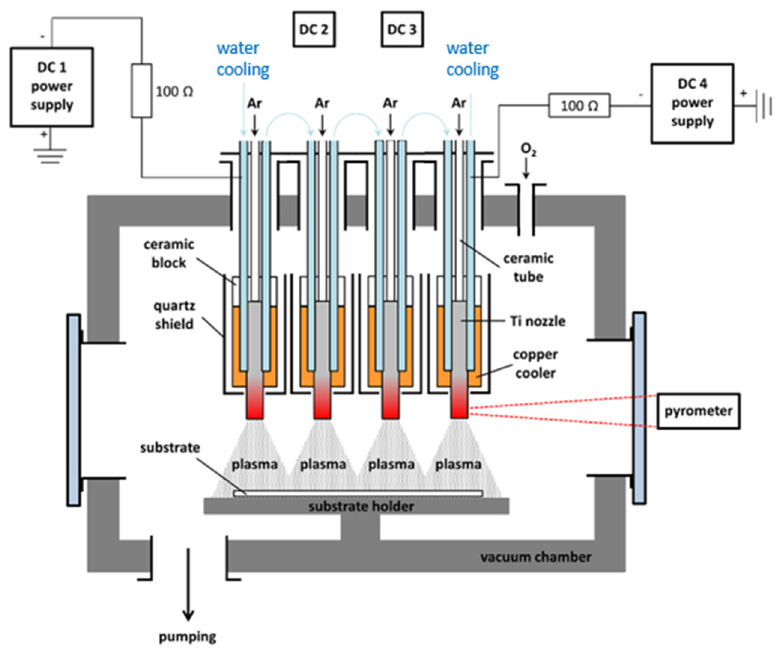
Figure 1. Scheme of multi-plasma-jet system with four independent DC hollow cathodes used for deposition of hierarchical TiO 2 Spikelet layers.